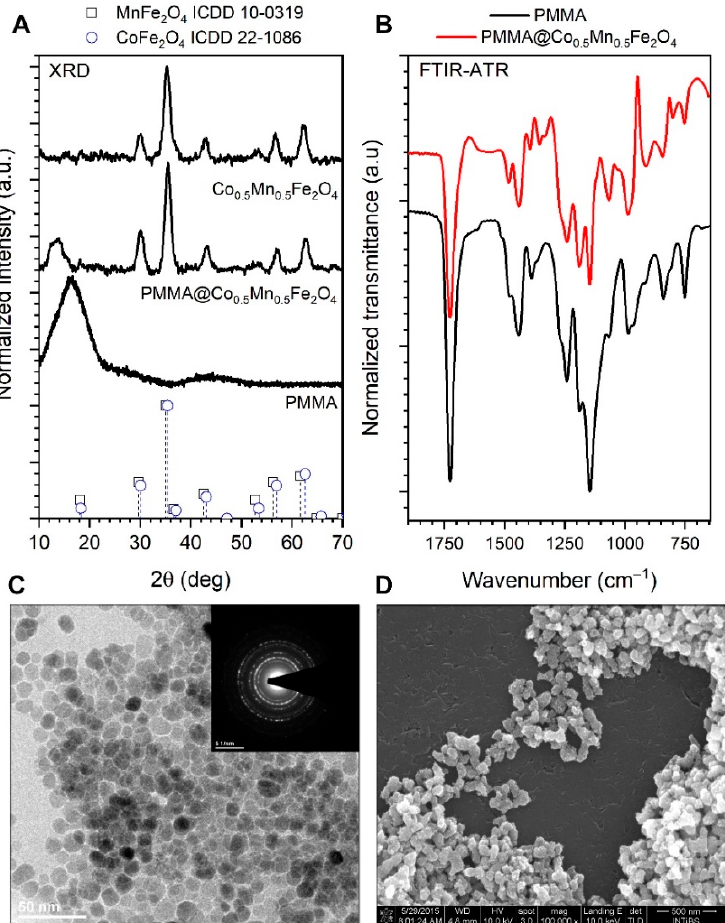
Figure 2. X-ray diffraction patterns of the Co 0.5 Mn 0.5 Fe 2 O 4 and Co 0.5 Mn 0.5 Fe 2 O 4 @PMMA ( A , B ) FTIR-ATR spectra of the reference PMMA and composite sample; ( C ) TEM and SAED images of the Co 0.5 Mn 0.5 Fe 2 O 4 nanoparticles, as well as ( D ) SEM picture of the binary hybrid.